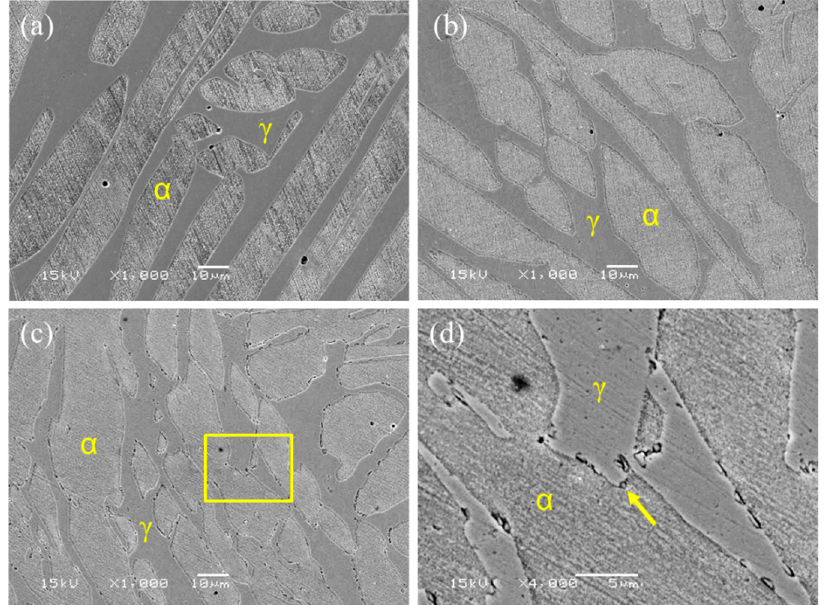
Figure 1. SEM images of the 2205 duplex stainless steel (DSS) specimens. ( a ) 2205 after solution treatment, indicating the α and γ duplex phases; ( b ) 2205Ag after 450 °C aging treatment for 1 h, indicating the α and γ duplex phases; ( c ) 2205Ag after 450 °C aging treatment for 4 h; ( d ) a magnified view of the region marked by the yellow box in ( c ), indicating the α , γ , and silver nano-precipitate (Ag-NP) phases (yellow arrow).